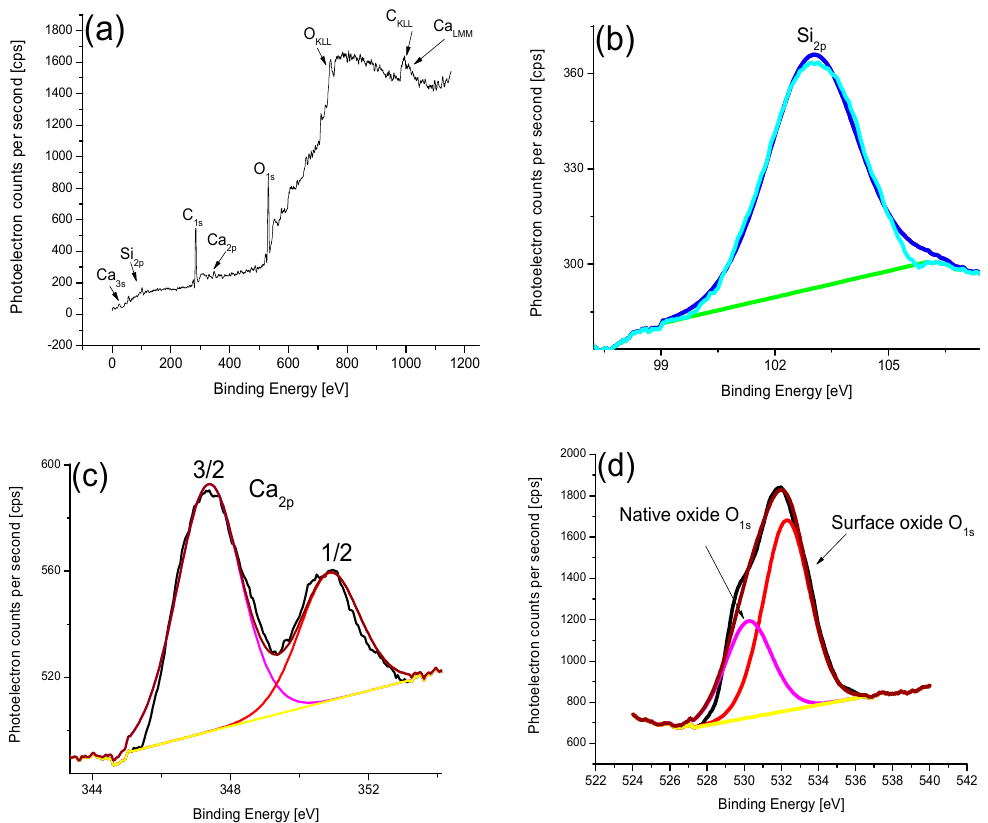
Figure 7. ( a ) X-ray photoelectron spectroscopy (XPS) survey spectrum of waste sand sample showing XPS peaks for silicon, calcium oxygen, and atmospheric carbon. High-resolution XPS spectra for Si2p, Ca2p and O1s XPS peaks are shown in ( b – d ), respectively.